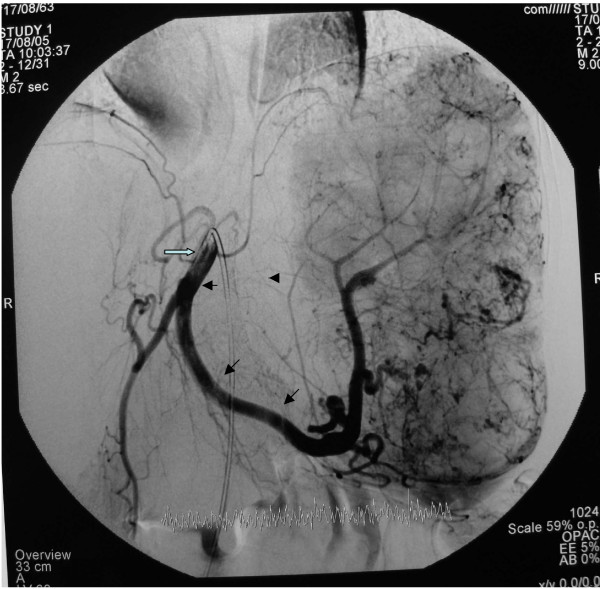
Angiographic appearance of cavernous splenic hemangioma. 1. Splenic artery (black arrows). 2. Celiac trunk (white arrow).